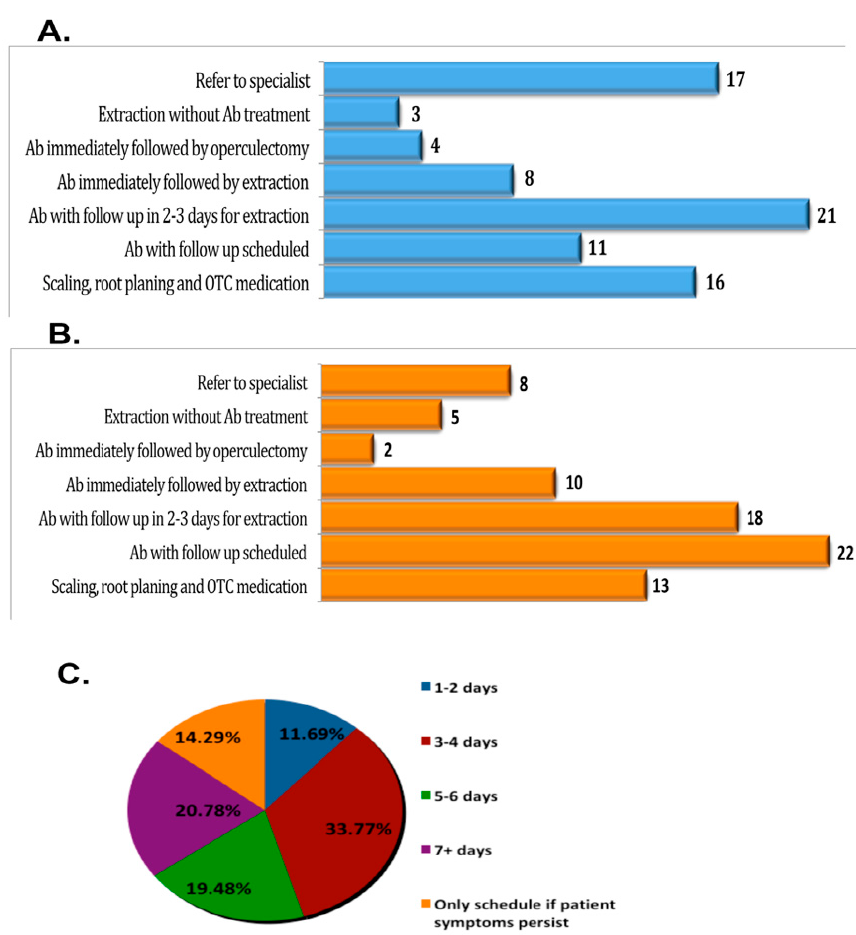
Figure 1. Survey results and data analysis of ( A ) providers indicate their preferred method of treatment for emergency patients presenting with acute pericoronitis of third molars. Prescribing antibiotics and scheduling a follow up appointment was reported as the most common treatment option. ( B ) Providers indicated which treatment most satisfies patient expectations on the initial emergency appointment with acute pericononitis. ( C ) The pie chart refers to the number of days to wait for a follow-up after prescribing antibiotics. The follow up timeline varied between providers. About 33.77% of dentists, a majority in this study, indicated that the preferred method of treatment for pericoronitis is antibiotic prophylaxis with follow up scheduled three-to-four days for treatment or